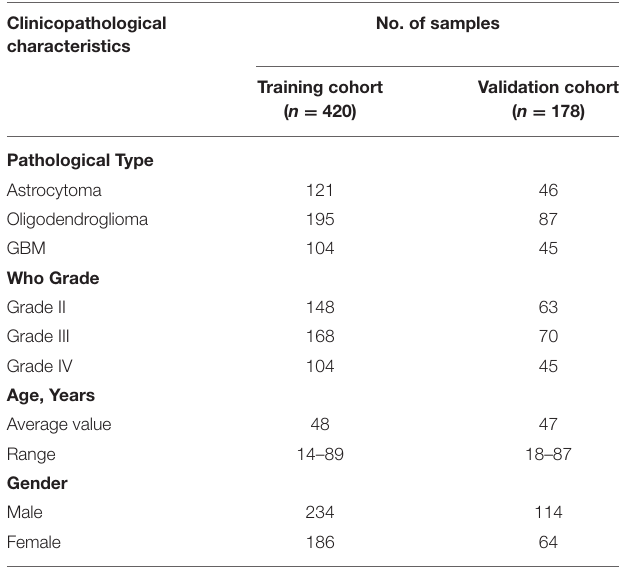
TABLE 1 | Clinicopathological characteristics of samples in the training cohort and the validation